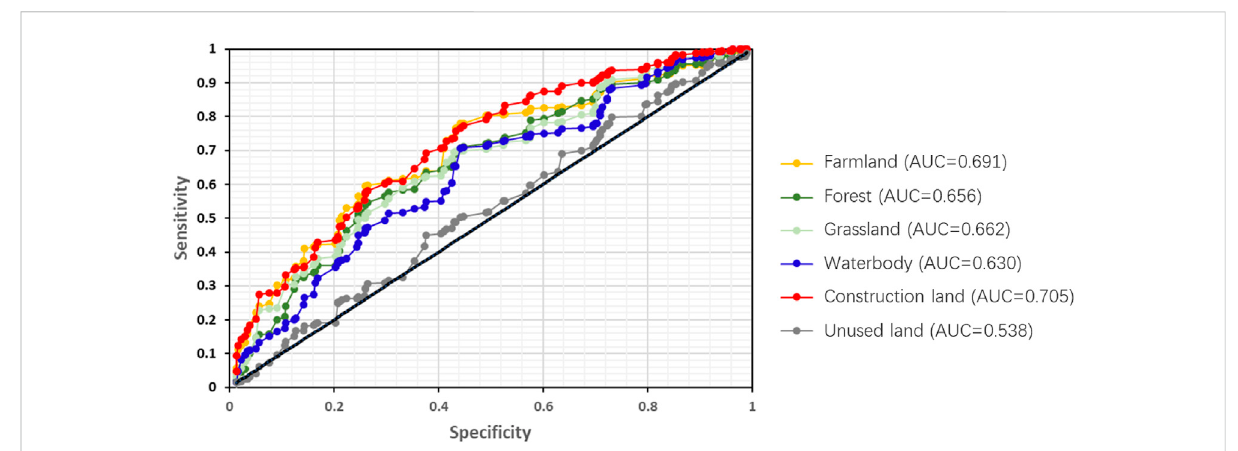
FIGURE 7 ROC curve and AUC value of land use after the ANN